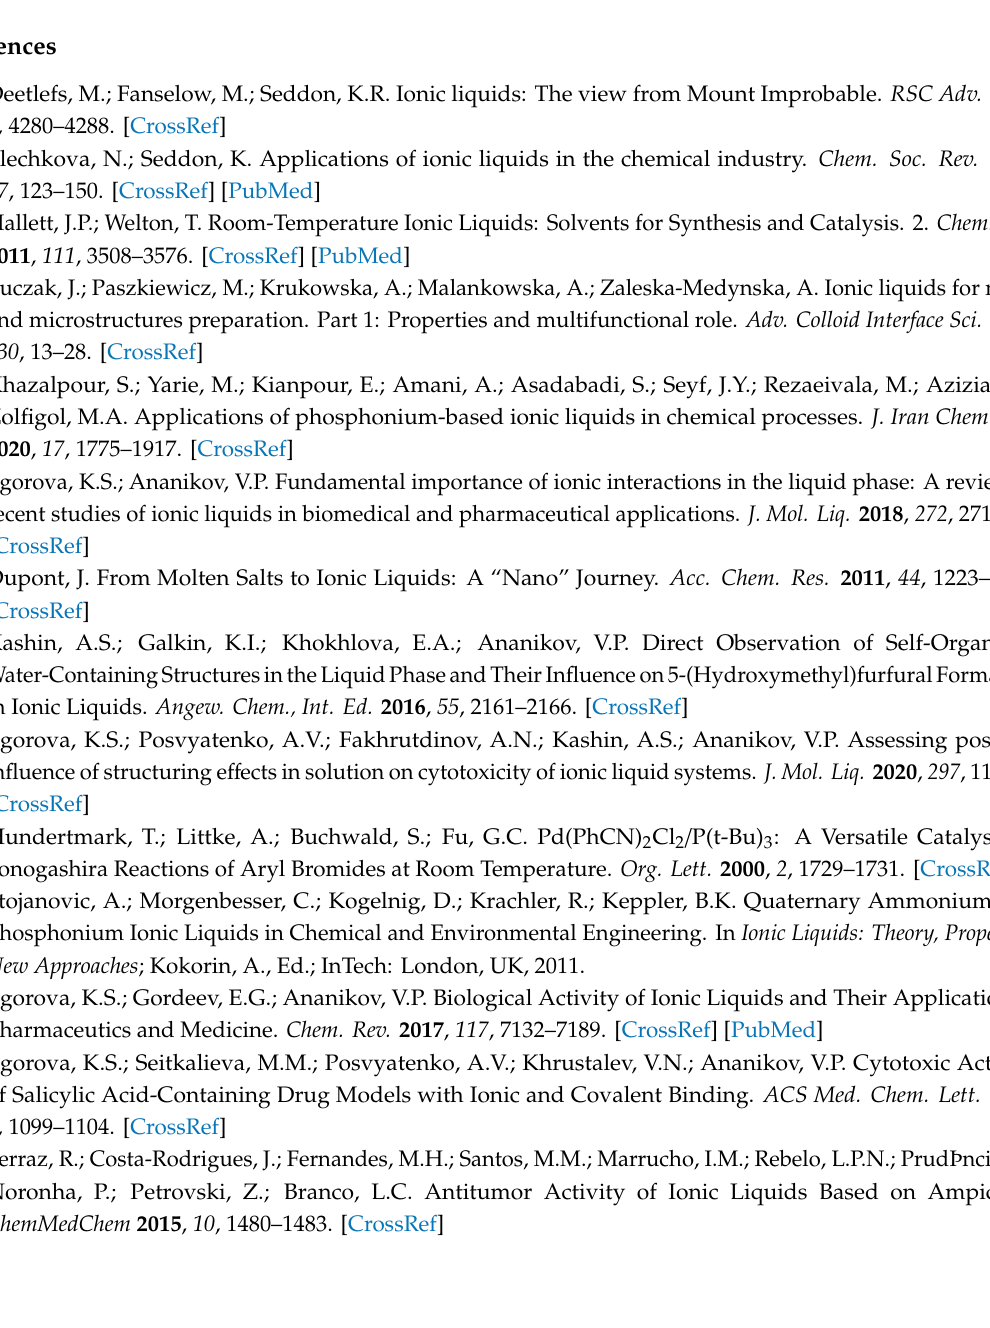
calculated curve, Figure S2: Screenshots of the 2D small-angle scattering pattern of the Pd@10b sample and SAXS di ff raction intensity profiles (Intensity vs. s) at 23 ◦ C, Table S1: The sizes of palladium crystallites, calculated from the parameters of di ff raction peaks, for Pd@5b sample, Table S2: Calculated parameters for the samples Pd@10b and Pd@5b, Figure S3: The fitting of experimental SAXS curve for samples Pd@5b and Pd@10b in the case of Guinier-Porod